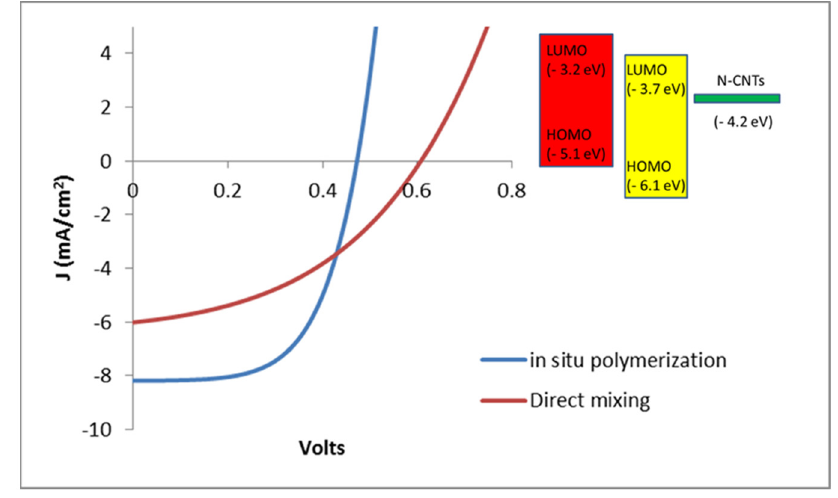
Figure 9. J-V curves of the devices from the two